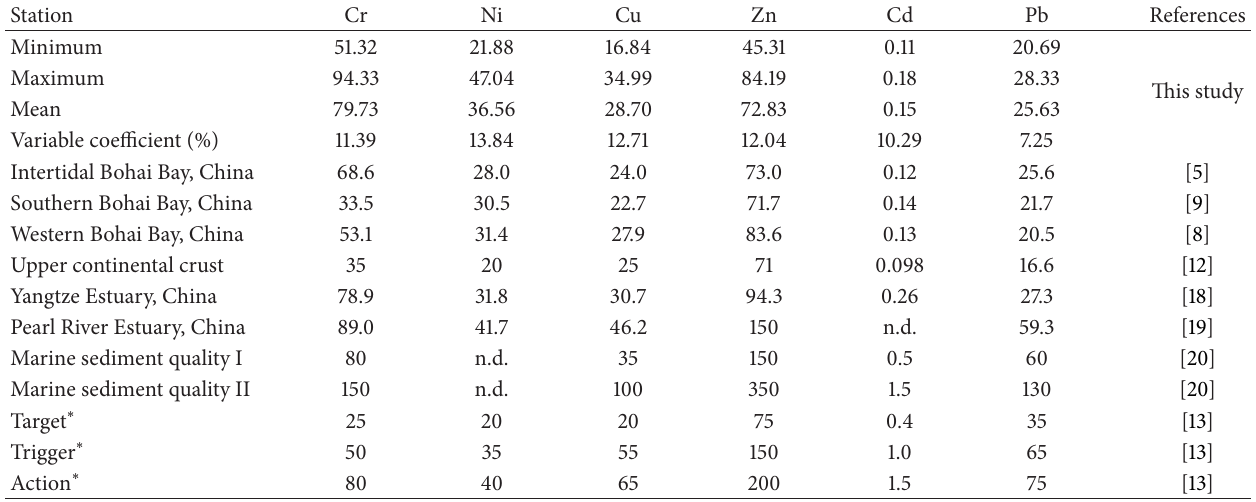
∗ Target indicates the desired quality for fairly clean sediment that is close to background levels. Trigger indicates that the sediment is moderately contaminated. Action indicates heavily polluted sediments.